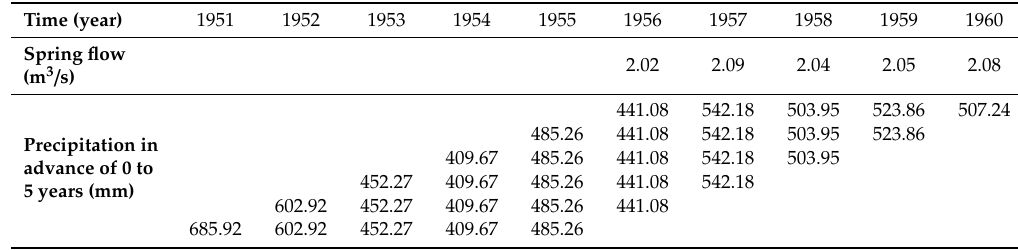
Table 1. Observed data of Jinci Springs flow and precipitation.